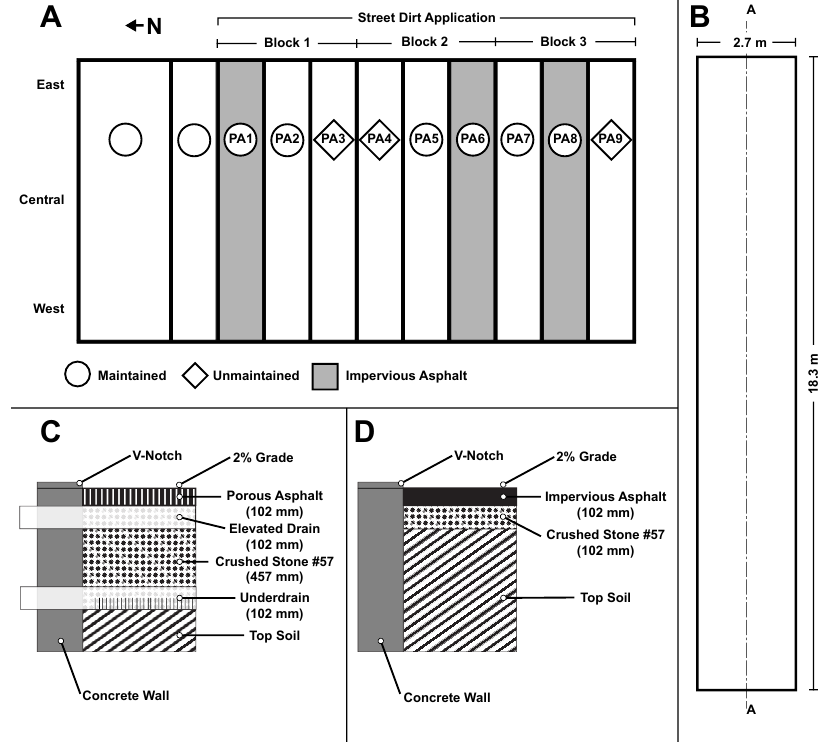
Figure 1. ( A ) Site plan of the porous asphalt cells. Maintained cells were cleaned annually with a regenerative air street sweeper. ( B ) Dimensions of each test cell. The dashed line (A-A) shows the cross-section locations of porous asphalt ( C ) and impervious asphalt ( D )